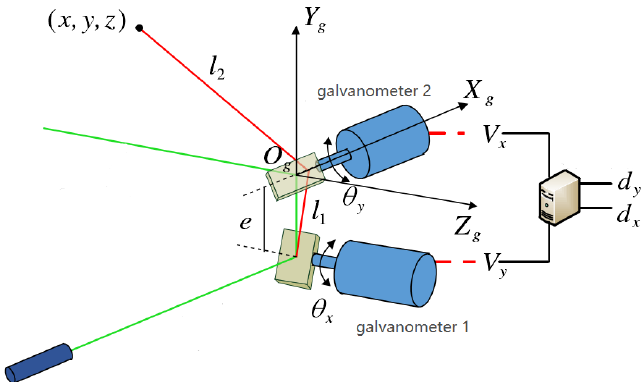
Figure 3. Physical model diagram of 2D galvo scanner. The green lines indicate that the laser is emitted along the coordinate axis, and the red lines indicate that the laser is emitted along any direction.